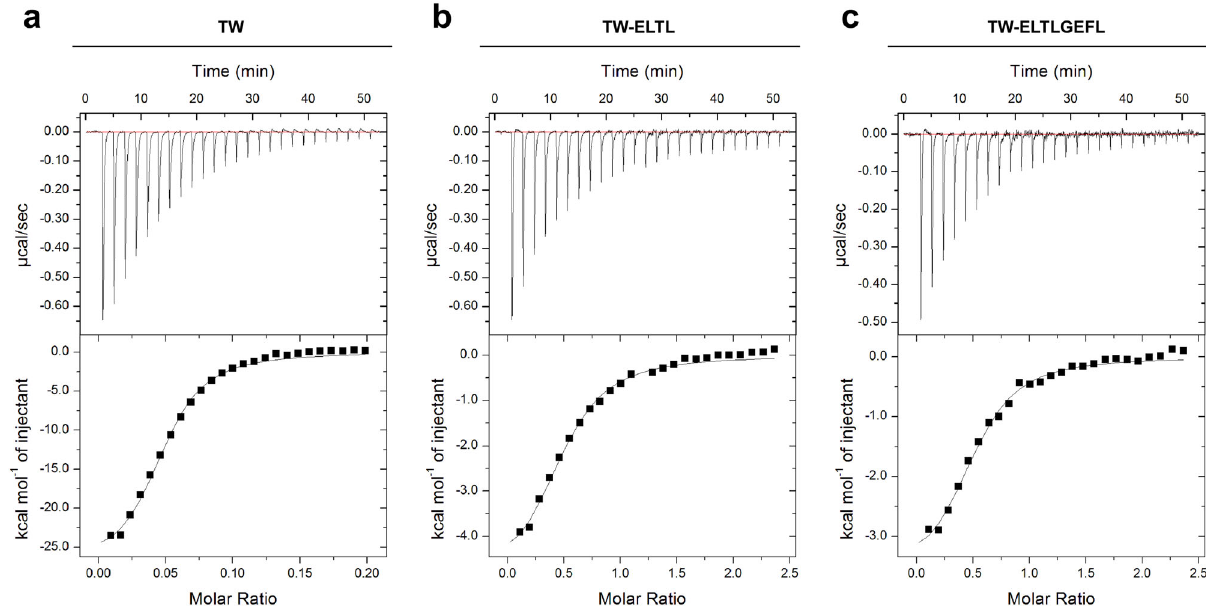
Fig. 3 Evidence for tweezer binding to Survivin120 from ITC measurements. Titration of 300 μ M TW ( a ) in the cell with 300 µ M Survivin120 in the syringe. Titration of 100 µ M TW-ELTL ( b ) and TW-ELTLGEFL ( c ) in the cell with 1.2 mM Survivin120 in the syringe. All titrations were performed in PBS, pH 7.4 at 25 °C. The black lines in the bottom panels are the best fi t of the data to a one set of sites model. The heat of dilution was subtracted as constant. Dissociation constants were determined to be 38 ± 4 µ M for TW, 24 ± 4 µ M for TW-ELTL and 19 ± 3 µ M for TW-ELTLGEFL. Values reported are the mean ± SEM of the fi t. For thermodynamic parameters see SI7. Source data are provided as a Source Data fi